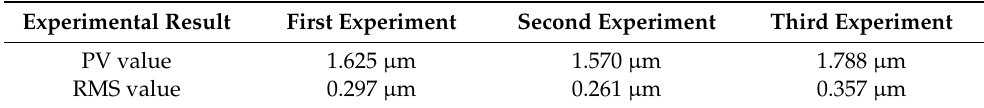
Figure 5. Morphological distribution of cutting errors at ( a ) the first cutting, ( b ) the second cutting, and ( c ) the third cutting. Table 2. Cutting error repeatability test results.